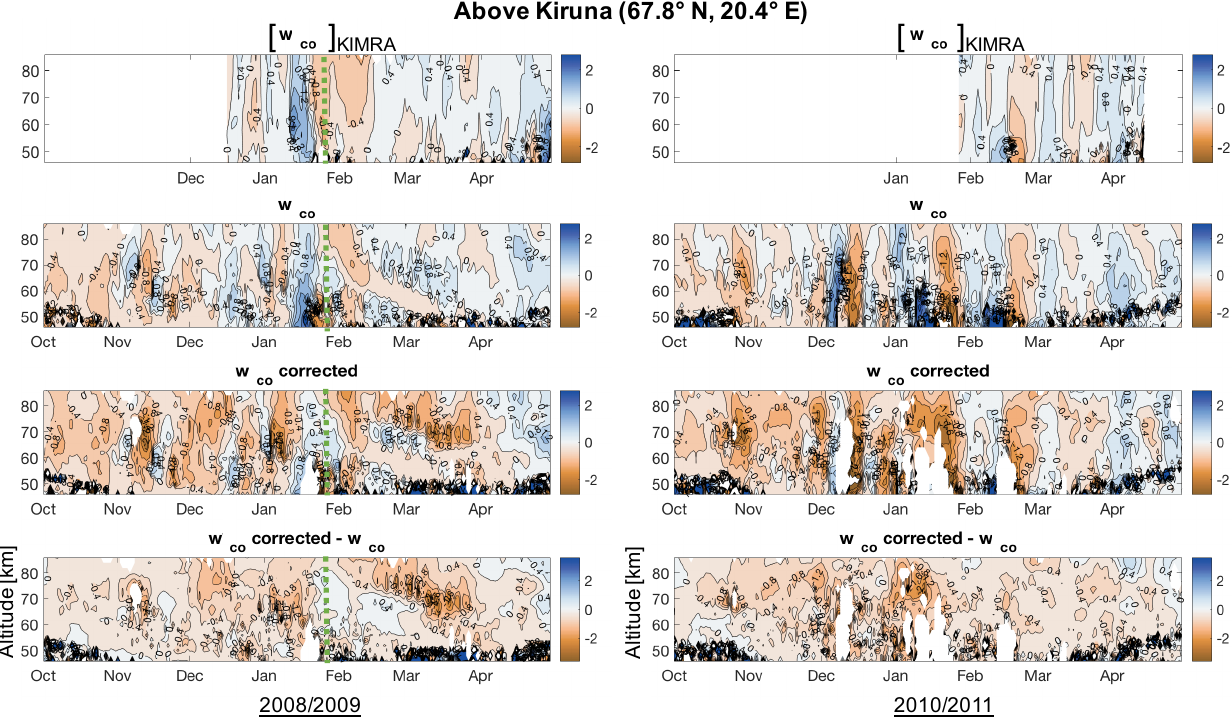
Figure 6. Rates of vertical motion, inkmday − 1 , calculated by tracking CO VMRs over time. w CO is calculated using daily averaged SD- WACCM CO profiles. w CO_corrected is calculated using a combination of SD-WACCM CO profiles and TEM tendencies (see Sect. 4 for details). The difference between the two rates of descent is also shown. The results plotted are for above Kiruna for the winters of 2008/2009 and 2010/2011. Contour lines are spaced by 0.2kmday − 1 . Areas with tightly packed contours (black areas) occur when there are very low CO VMRs and the calculation method is unreliable. White areas are where a CO VMR could not be tracked within the shown altitude range. The start date of the SSW on 28 January 2009 is shown with a vertical green dashed line. Rates calculated using KIMRA CO data are also included in the upper two panels, titled [ w CO ] KIMRA